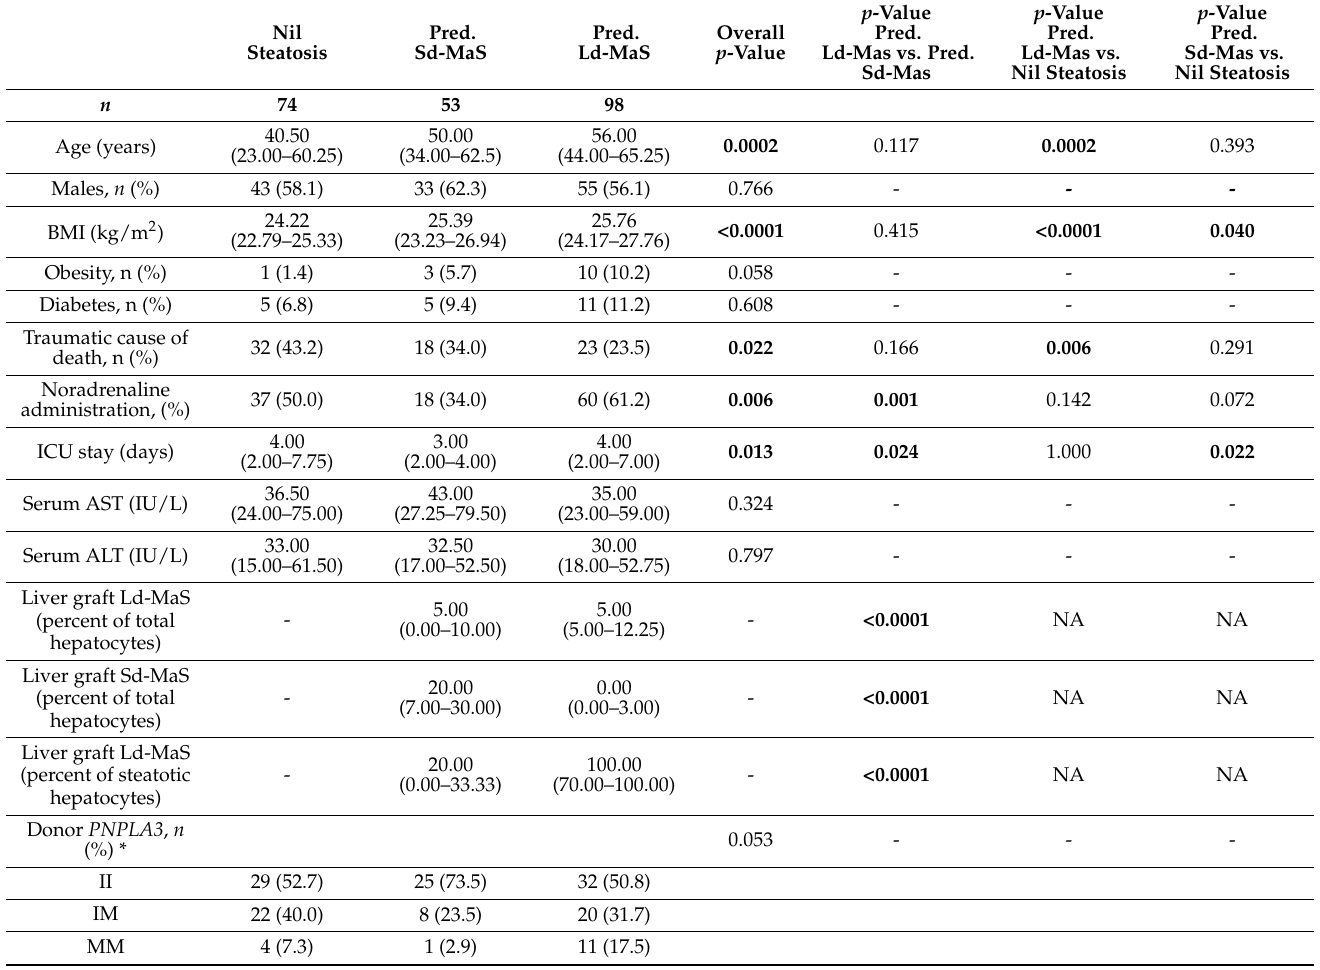
Table 1. Donor demographics, clinical characteristics, PNPLA3 variant and percentage distribution of Ld-Mas and Sd-Mas calculated both with respect to the total number of hepatocytes and to that of steatotic hepatocytes, according to the presence and the predominant type of